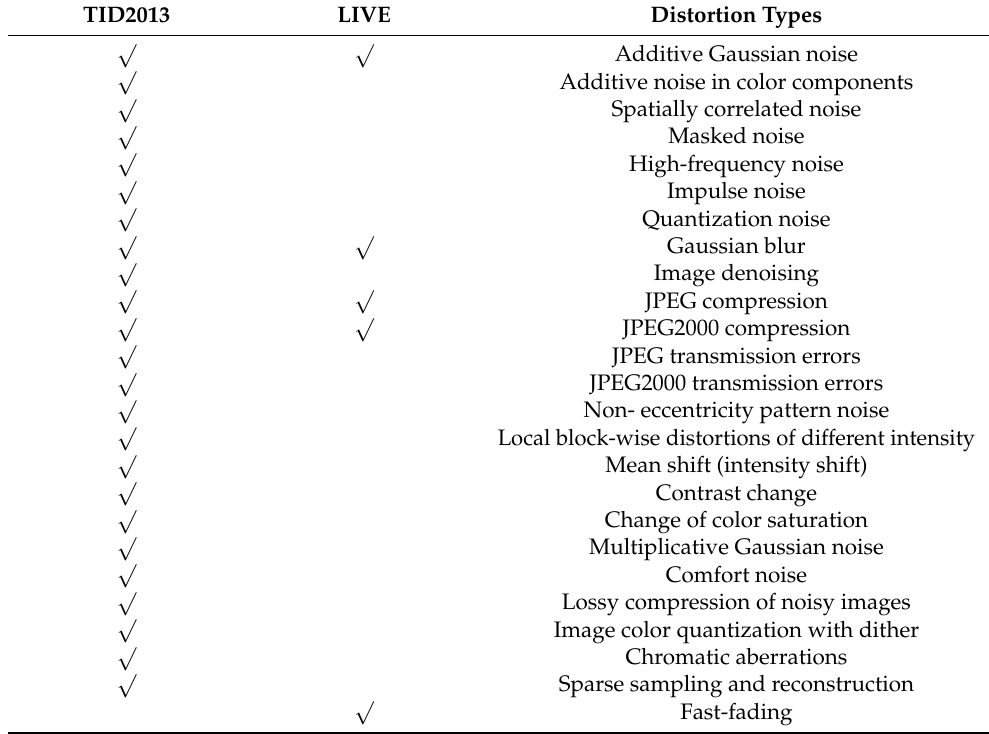
Table 1. Image distortion type.